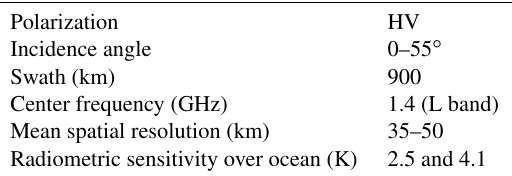
Table 3. SMOS sensor specifications.